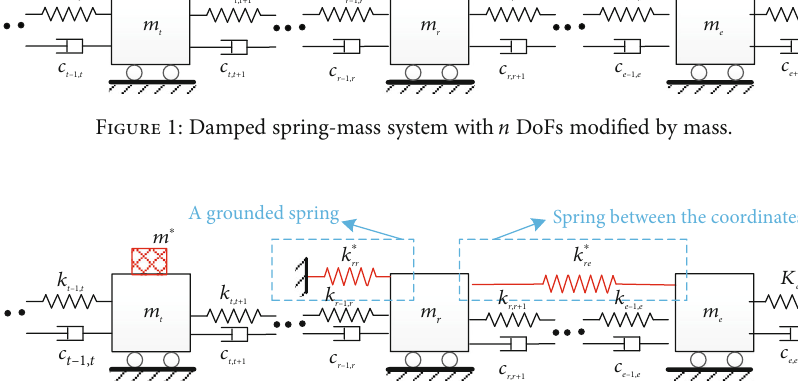
Figure 2: Damped spring-mass system with n DoFs modi fi ed by mass and a spring.